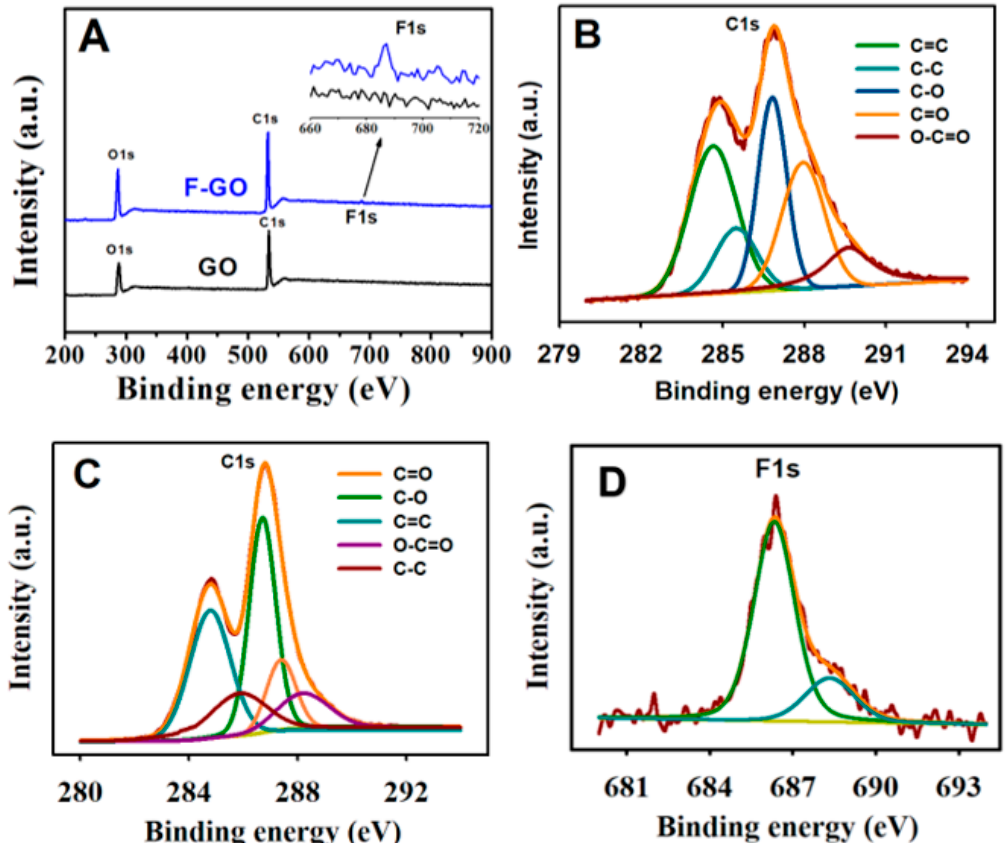
Figure 2. ( A ) The XPS spectra (survey scan) of GO and FGO; ( B ) high-resolution XPS spectrum of C1s of GO and the fitting curves; ( C ) high-resolution XPS spectrum of C1s of F-GO and the fitting curves; and ( D ) high-resolution XPS spectrum of F1s of F-GO.